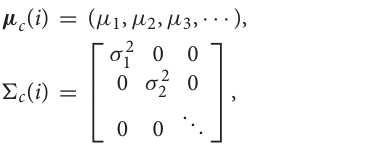
FIGURE 5 | Overview of the variational autoencoder (VAE). The low-dimensional latent variable z j is obtained by compressing the observed data point x j through the encoder network. x ′ j is an observation reconstructed by the decoder from the latent variable z j